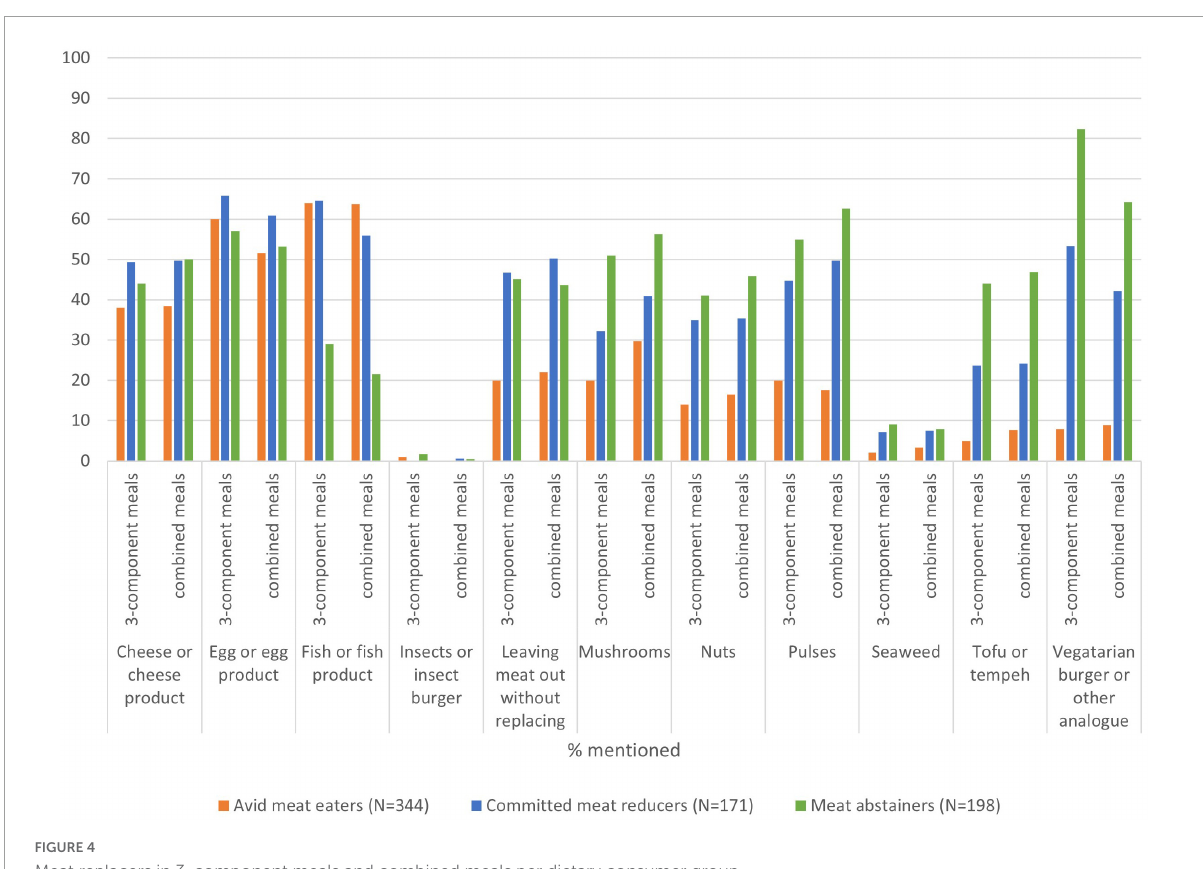
FIGURE4 Meat replacers in 3-component meals and combined meals per dietary consumer